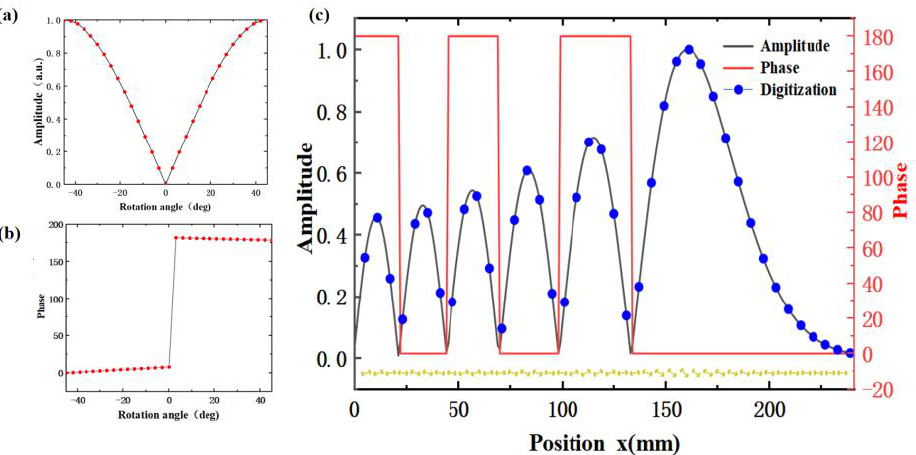
Figure 3. ( a ) Simulated amplitude transmission, and ( b ) phase for dumbbell–type structures at different angles, ( c ) amplitude and phase profile of the Airy beam generators along the x–direction, Location distribution of dumbbells along the x – direction.